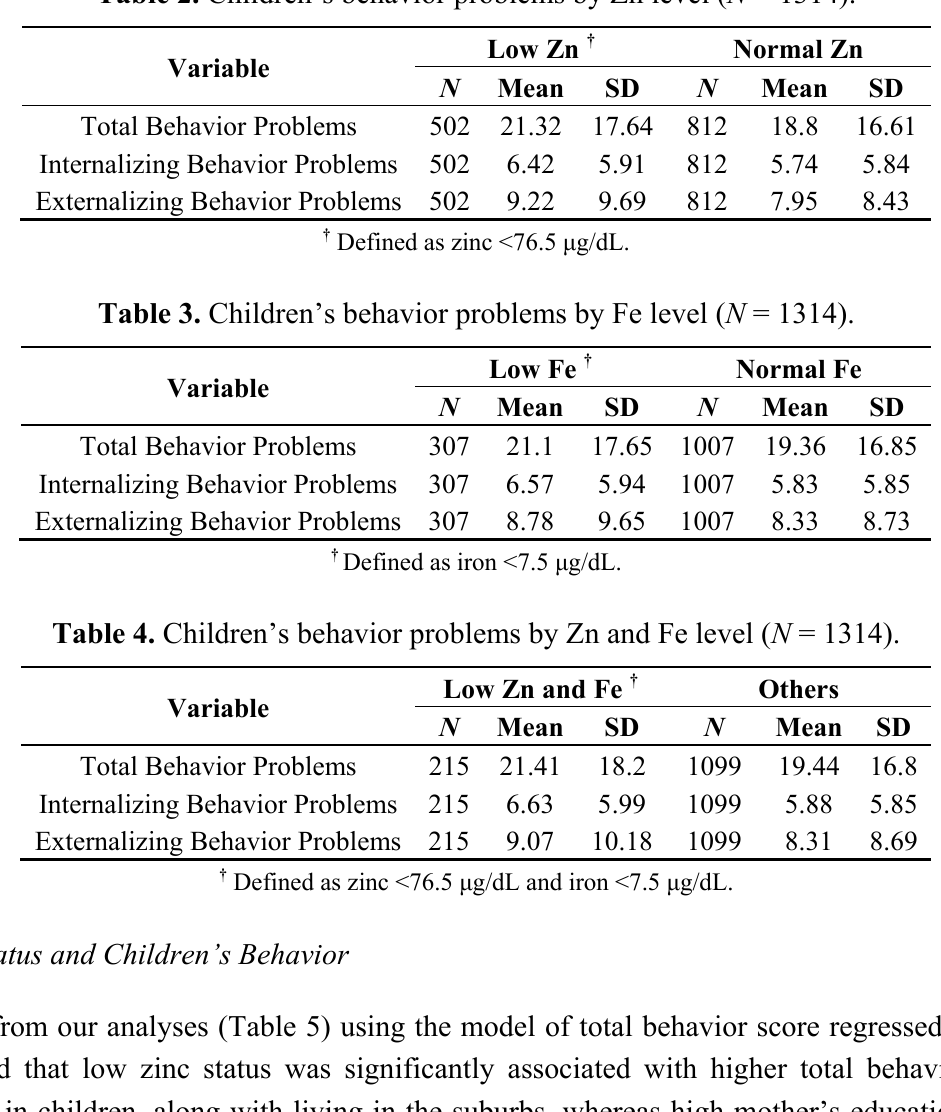
Table 2. Children’s behavior problems by Zn level ( N = 1314).